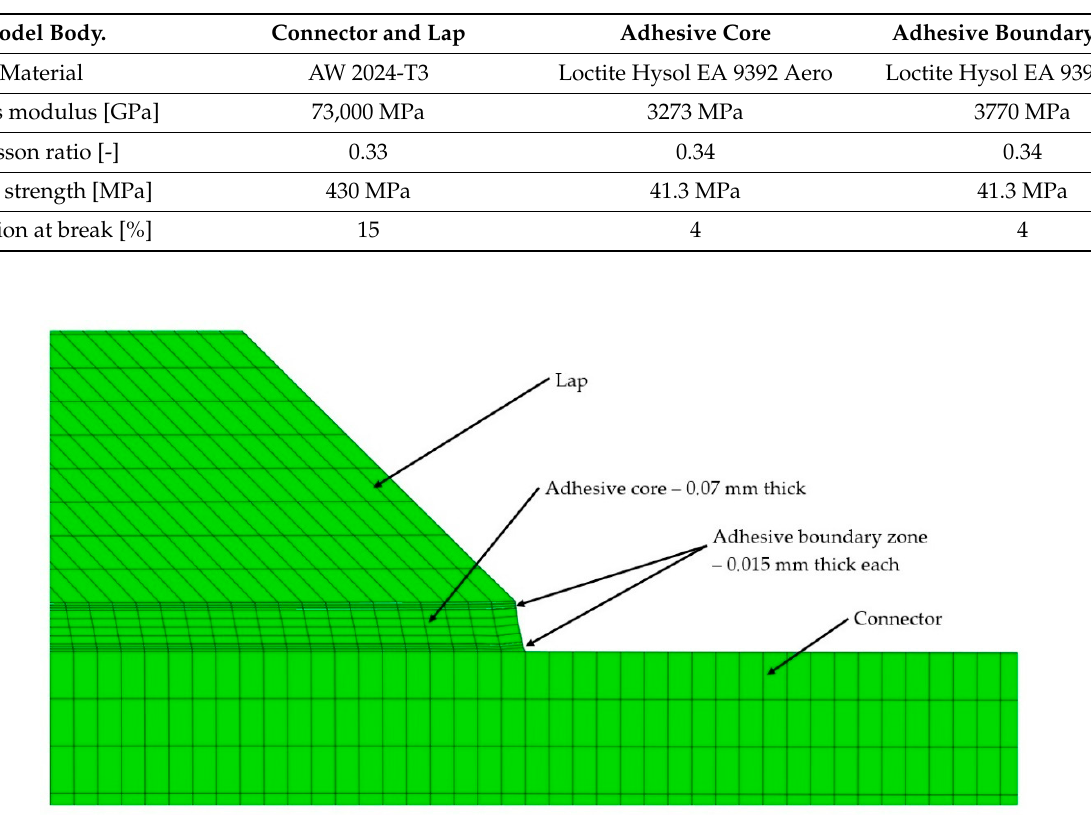
Figure 3. A detailed view of the numerical model with the presented division of the joint into three zones, with visible mesh density in the boundary zone. Table 1. Material properties of materials used in the FEM model. Model Body.